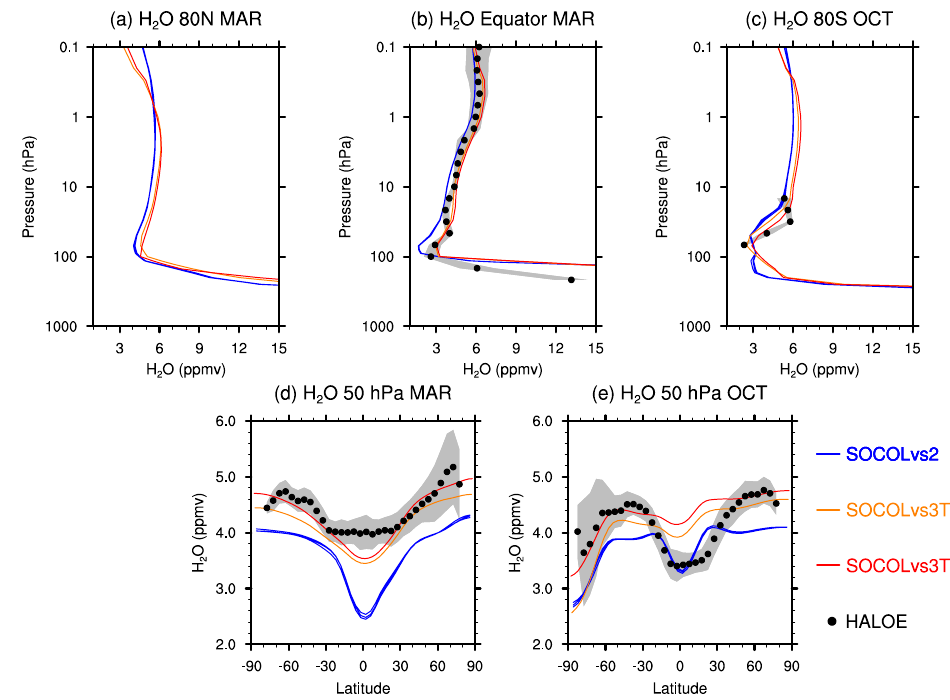
Fig. 7. Same as in Fig. 6 but for water vapor in